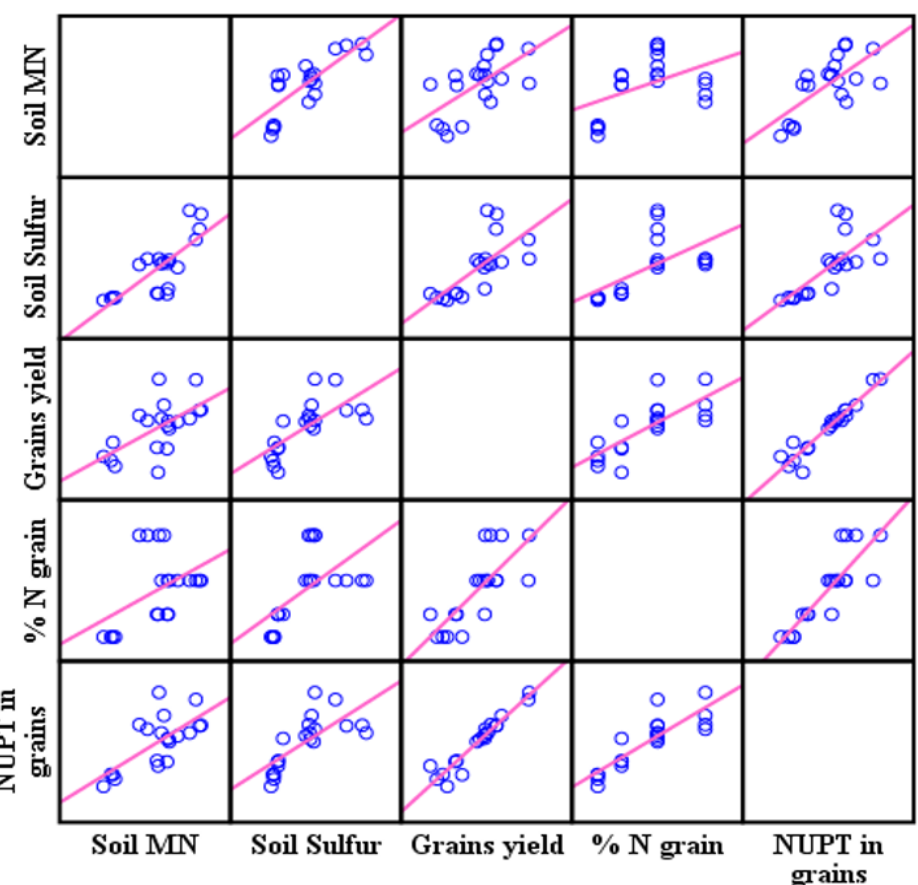
Figure 7. The correlation matrix relations effect of soil mineral N and sulfur on the N uptake in the grains, the grain’s total N , and the grain yield in 2019.